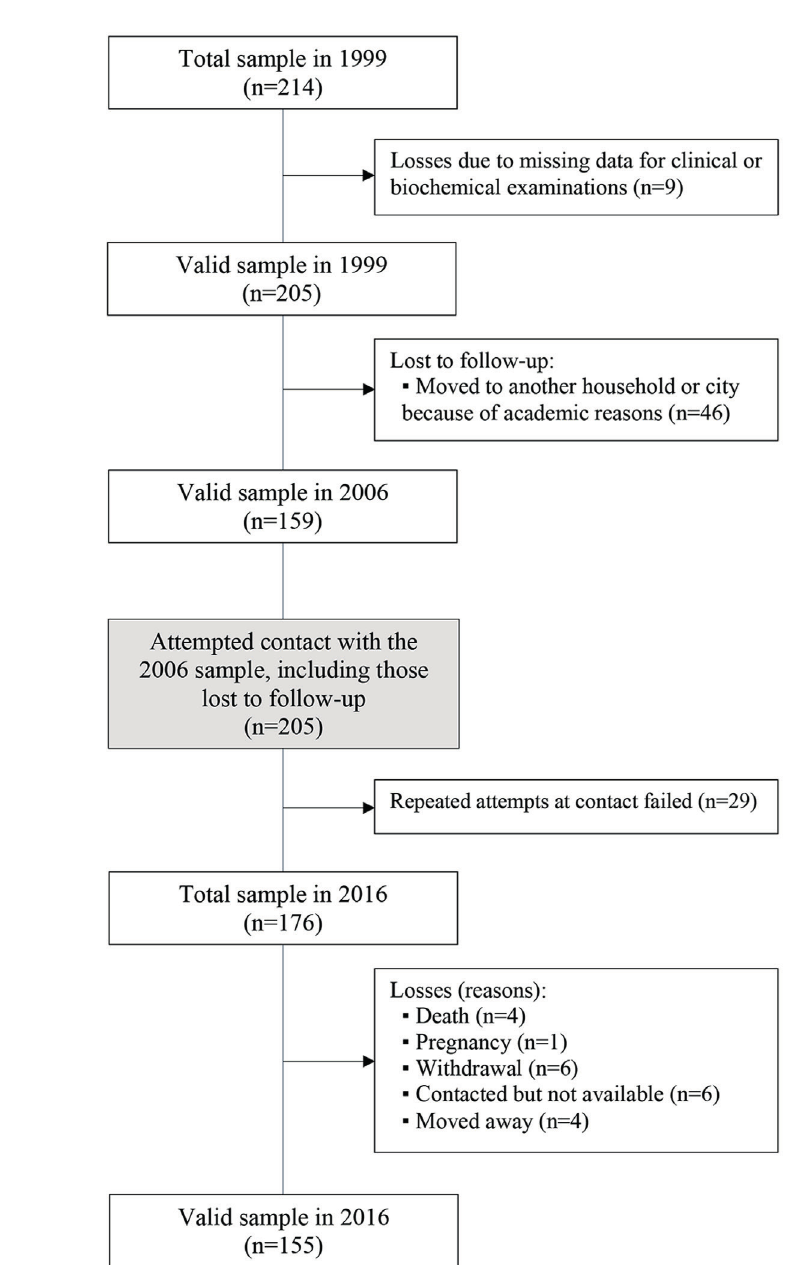
Figure 1 - Flowchart of study design with information on losses in